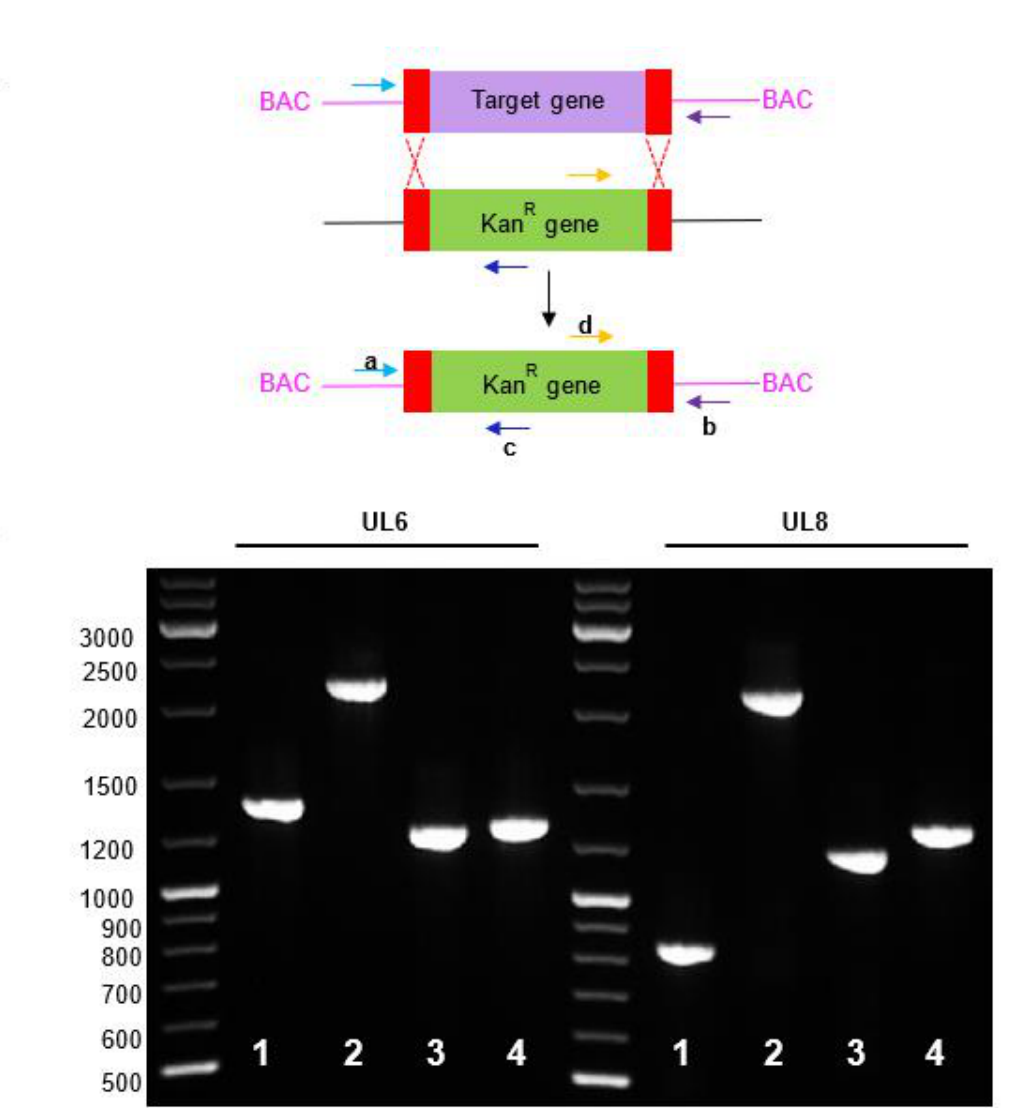
Figure 1. ( A ) Schematic representation of the homologous recombination system and the genomic location of the oligonu- cleotides used in the study. ( B ): PCR products obtained to confirm the indicated ∆ UL6 and ∆ UL8 gene deletion of the virus. PCR products were separated by electrophoresis in a 1.5% Agarose gel. Lane 1: amplification using the primers upstream and dowstream (ab) of the target gene using the wild-type BAC DNA (WT) as a template. Lane 2: amplification using the primers upstream and dowstream (ab) of the target gene using the indicated deletion mutant BAC DNA as a template. Lane 3: amplification using the primer upstream of the deleted gene and an internal Kan primer (ac). Lane 4: amplification using the internal Kan primer and a primer downstream of the deleted gene (db). One kb DNA molecular weight marker was used as a ladder.